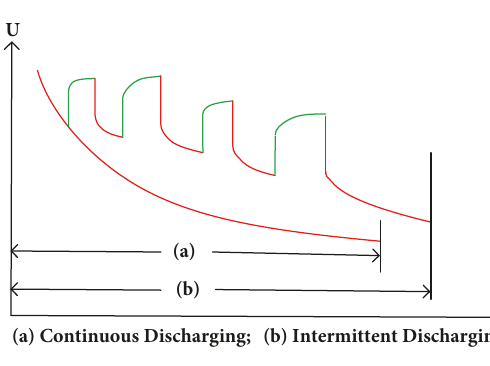
Figure 2: Comparison of lithium battery continuous discharge and intermittent